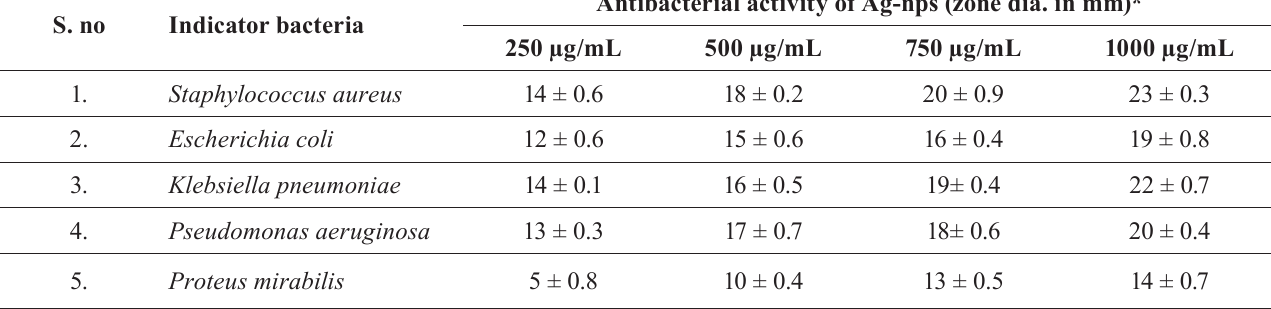
TABLE III - Results of assay of antibacterial activity of silver nanoparticles S. no